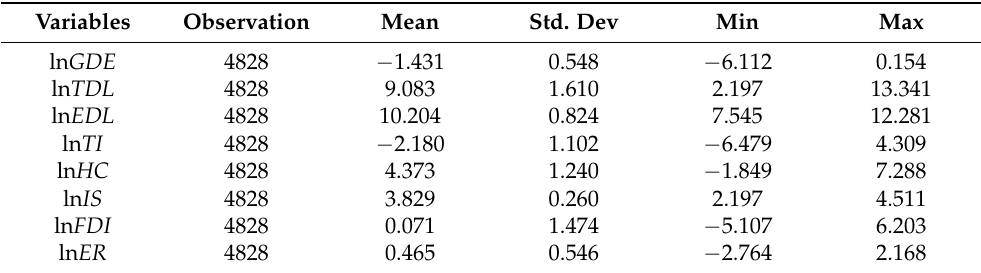
Table 1. Descriptive statistics of main variables. Variables Observation